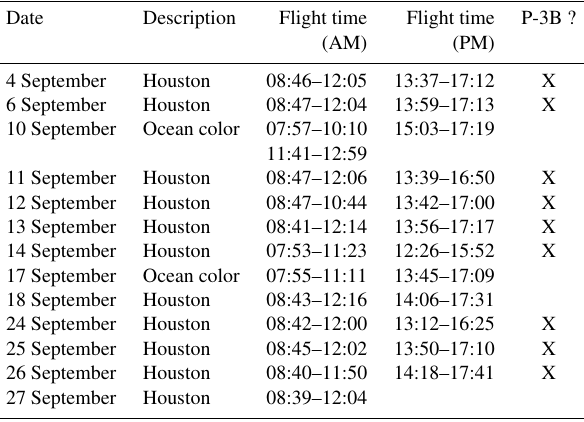
Table 1. Summary of GCAS flights during DISCOVER-AQ Texas 2013. Times are local time (LT: UTC − 5h). Days with P-3B air- craft flights are denoted by an X in the rightmost